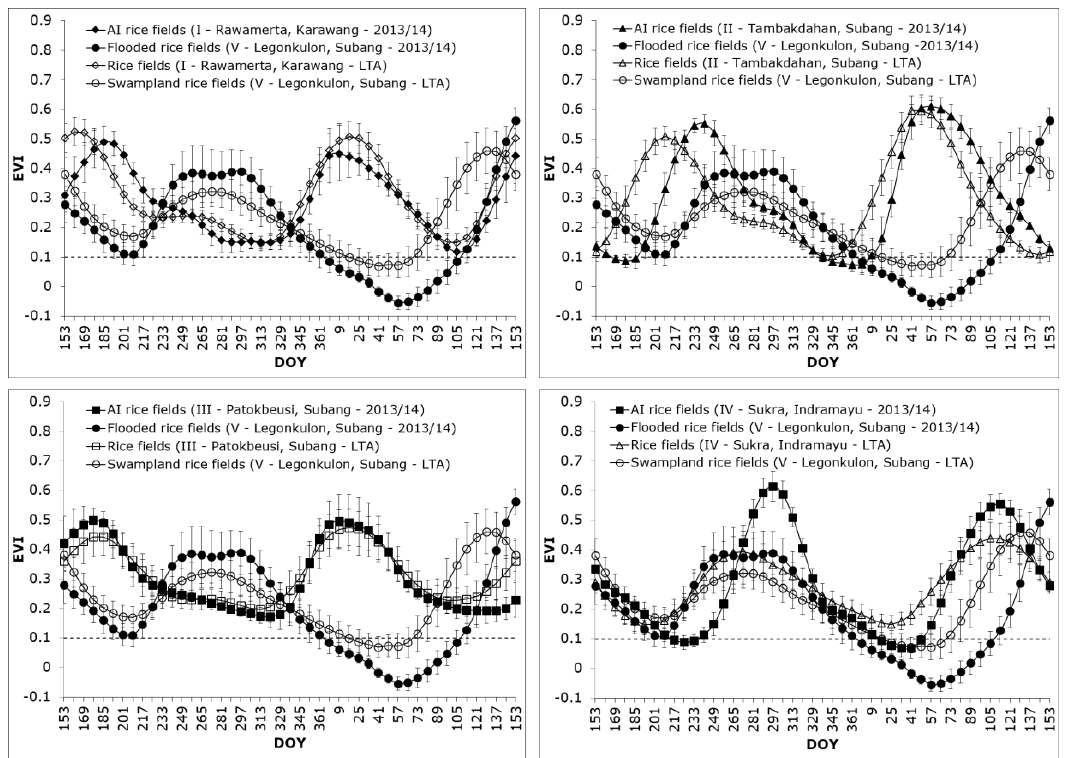
Figure 5. EVI profiles (average of 5 × 5 pixels) in rice fields with flooding and rice fields with agronomic inundation in 2013/2014 (AI, solid markers) and Long-Term Average 2000–2015 (LTA, open markers). Symbols I–IV and V correspond to the yellow dots and the red dot Figure 1A, respectively.